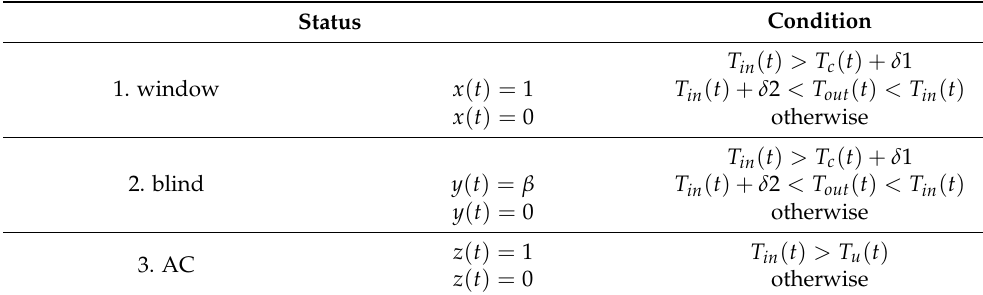
Figure 3. The Control System Architecture. Table 3. Control logics of window, blind and Air Conditioning (AC) applied by Building Energy Management System (BEMS) if occupancy is detected.